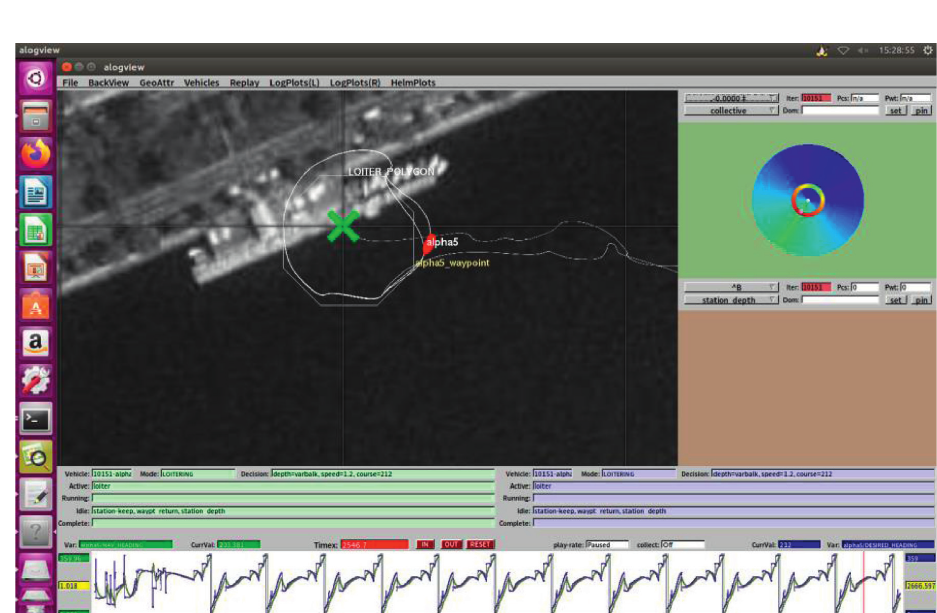
Figure 7: The waypoints tracking control result, nav_heading, and desired_heading plots in MOOS-IvP alogview.